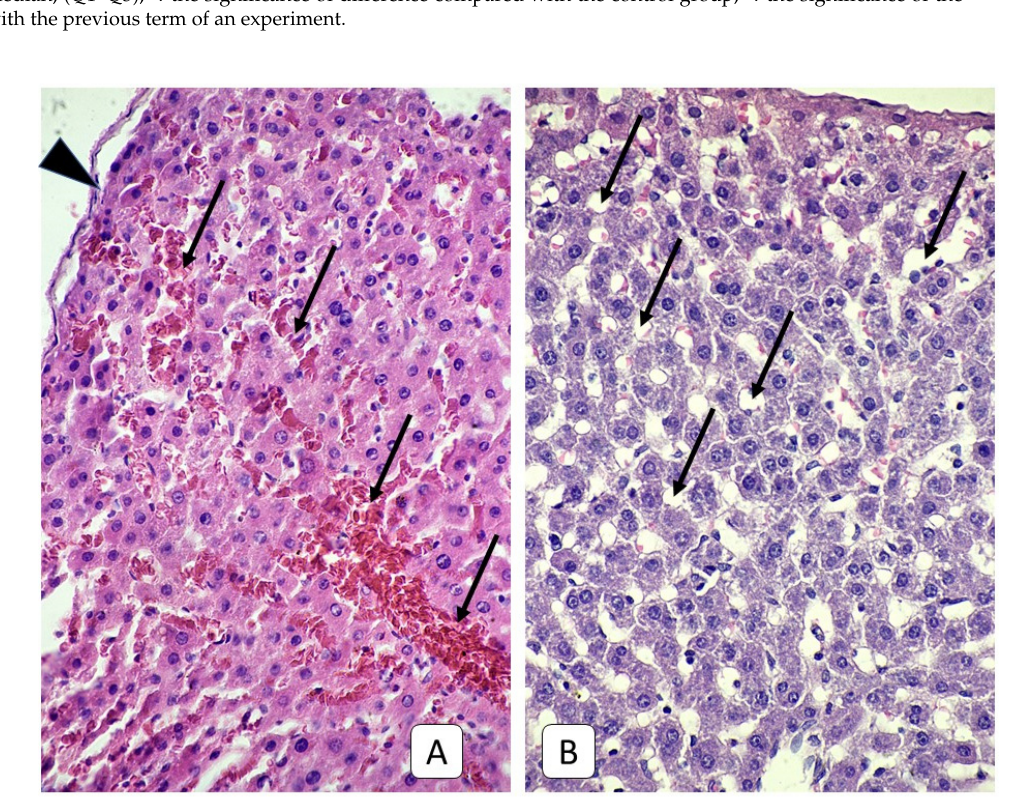
Figure 2. Photomicrograph of the liver. ( A ): adult rats, 1st day after mTBI. Dilated sinusoidal capillaries (arrow) near the liver capsule (arrowhead) with blood stasis and RBC sludges having occurred. ( B ): control group. Sinusoidal capillaries (arrow) of the subcapsular area. H E, ×400.